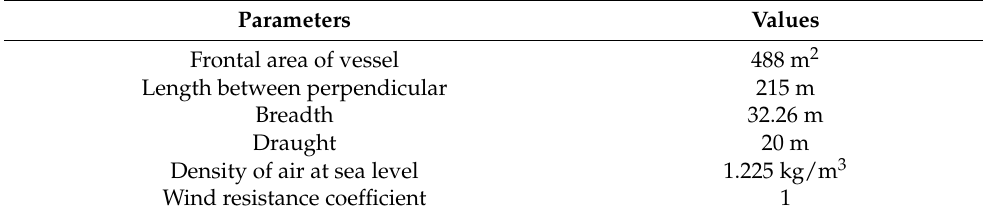
Table 14. Vessel parameters and other information for resistance